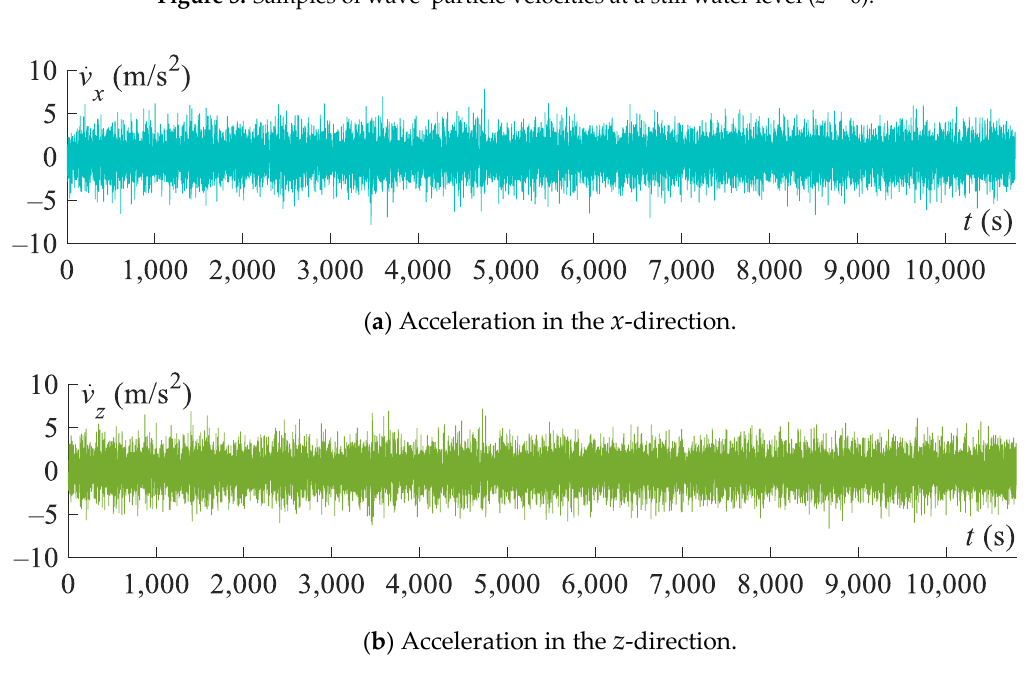
Figure 4. Samples of wave–particle accelerations at a still water level ( z = 0).